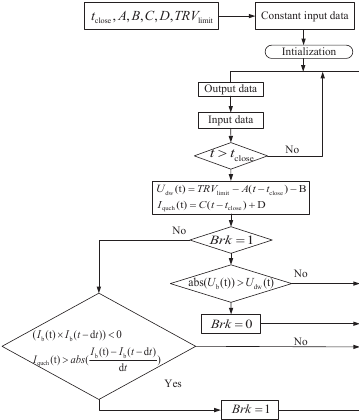
Figure 2. Flow chart of the closing model for a vacuum circuit breaker